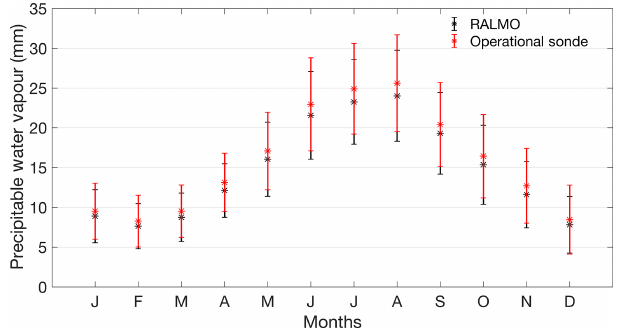
Figure 5. The PWV climatology of both the lidar and the opera- tional radiosondes. The error bars are the 1 σ standard deviation of all of the measurements in each month. The climatology was cal- culated using the same dates for both the radiosonde and the lidar measurements.